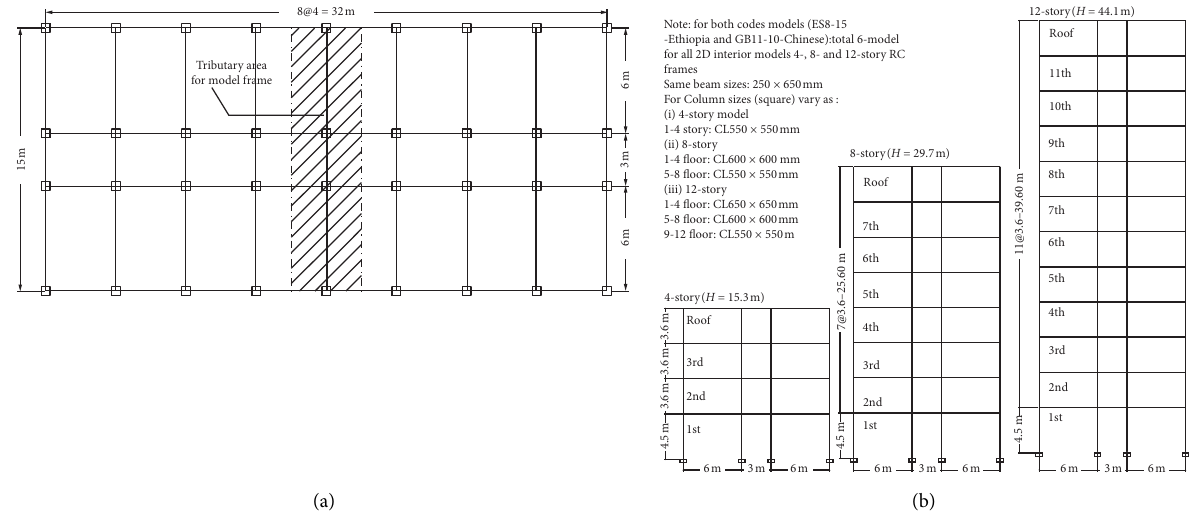
Figure 1: (a) Typical floor plan of A and B model building [27] and (b) 4-, 8-, and 12-story model frames of A and